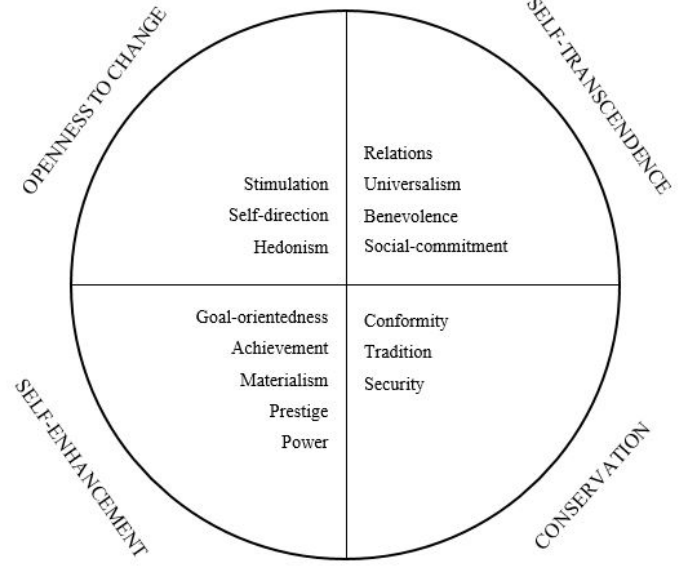
Figure 1: Theoretical model of relations among 15 motivational types of values by De